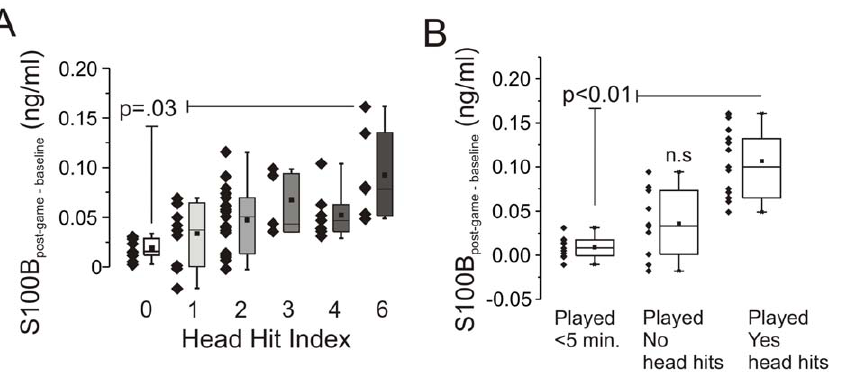
Figure 3. S100B increase in serum after games correlates with extent and number of head hits. A ) S100 post-game – baseline levels are significantly correlated to HHI scores (see Methods and Table S2). A statistically significant difference was found between HHI 0 and 6. Moreover, when S100 post-game – baseline values were plotted against HHI (0 to 6 as a continuous variable) a statistically significant correlation was observed (p , 0.05; R 2 =0.51). B ) S100 post-game – baseline values are elevated only in players who experience head hits. Measurements were obtained by film game review.